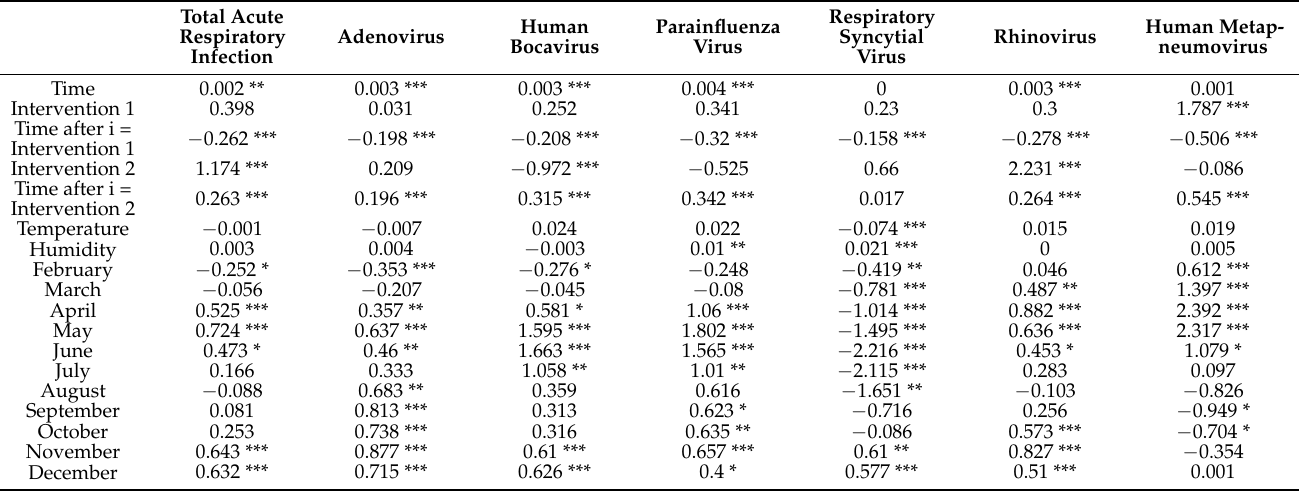
Figure 1. Time trends of hospitalization of acute respiratory infection inpatients. Table 1. Results of segmented regression analysis of the effect of COVID-19 on the number of inpatients with acute respiratory